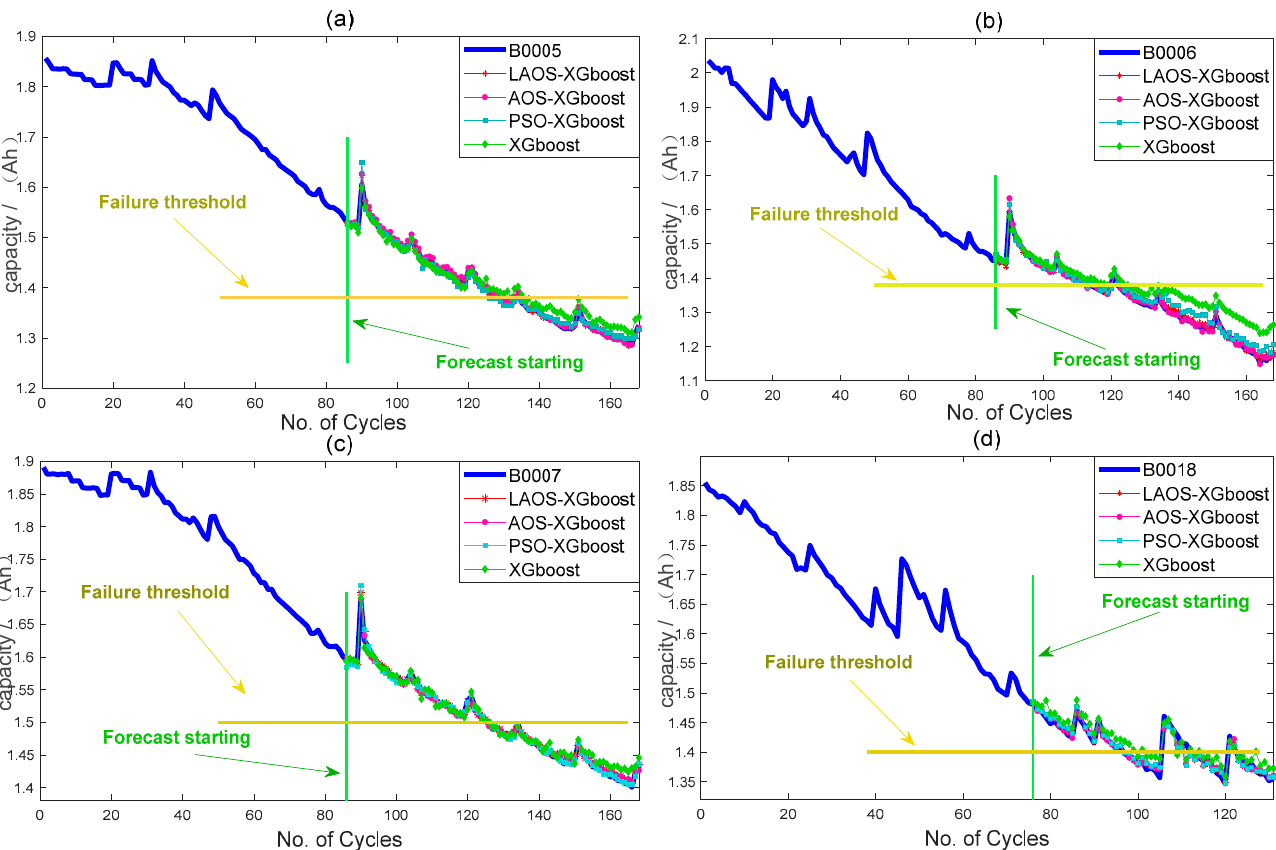
Figure 11. The SOH prediction of the same battery. ( a ) SOH prediction results of B0005 battery. ( b ) SOH prediction results of B0006 battery. ( c ) SOH prediction results of B0007 battery. ( d ) SOH prediction results of B0008